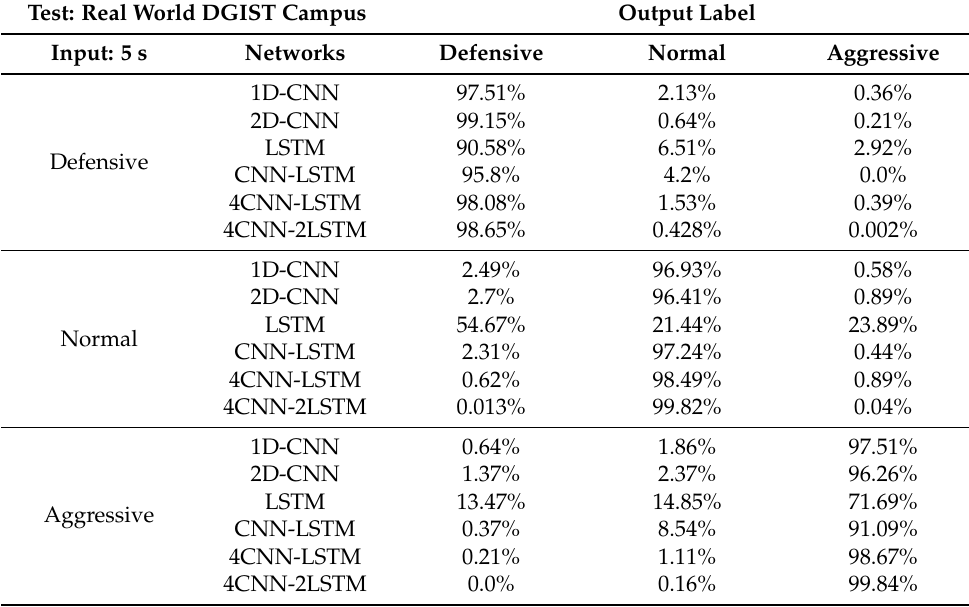
Table 9. Confusion matrix of driving behavior classification results in real world DGIST campus.